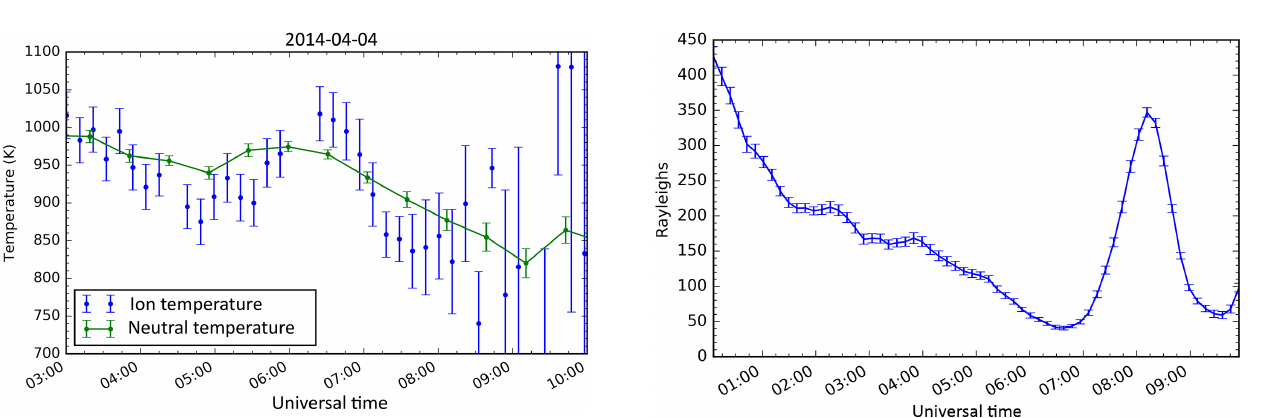
Figure 13. Measurement of brightness in rayleighs measured at zenith with the El Leoncito ASI throughout the night on 4 April 2014. Earlier in the night, in contrast to Jicamarca ASI ob- servations, there is the typical decrease in brightness as the iono- sphere decays. The increase in brightness later in the night, with a peak at about 08:00UT, is a brightness